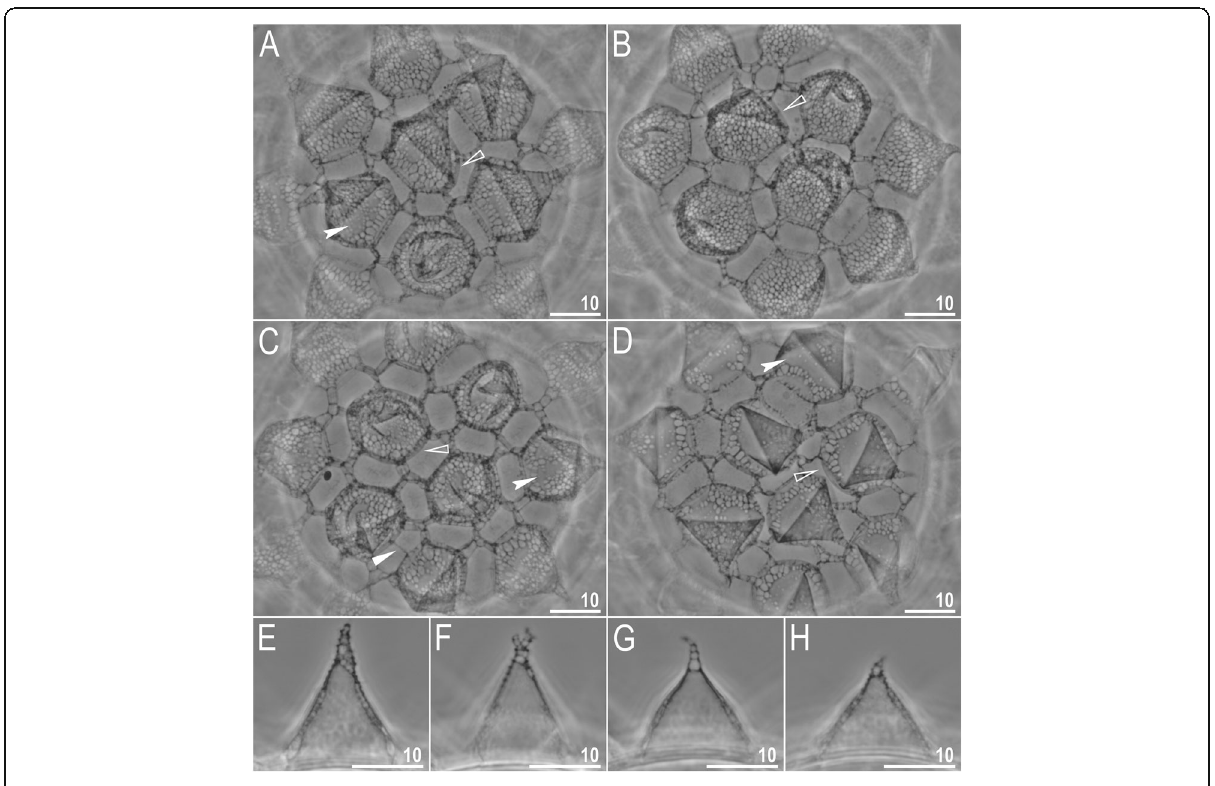
Fig. 18 Macrobiotus pseudopallarii sp. nov. from Montenegro (ME.007) – eggs seen with LCM: a – d – surface under ×1000 magnification of four different eggs; e – h – midsections of four different egg processes. The filled flat arrowhead indicates thickening perpendicular to the process base that divides the areola in the middle, filled indented arrowheads indicate areas of the egg processes without a reticulation/labyrinthine layer, and empty flat arrowheads indicate irregular collars around process bases. Scale bars in μ